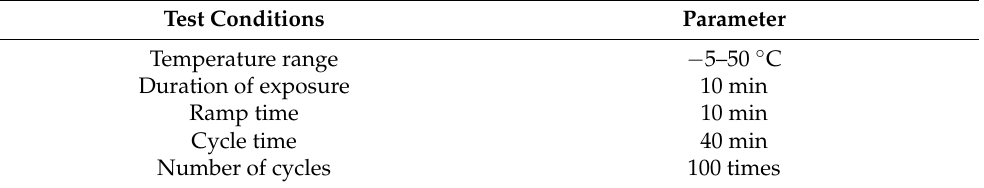
Table 7. Thermal cycling test condition.